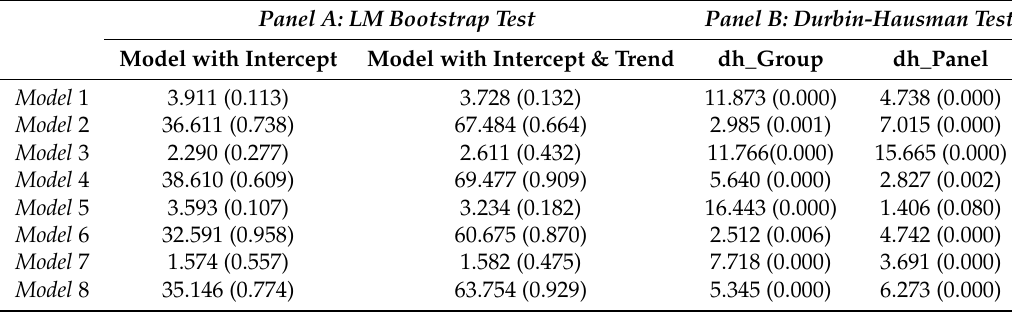
Table 4. Panel Cointegration Tests